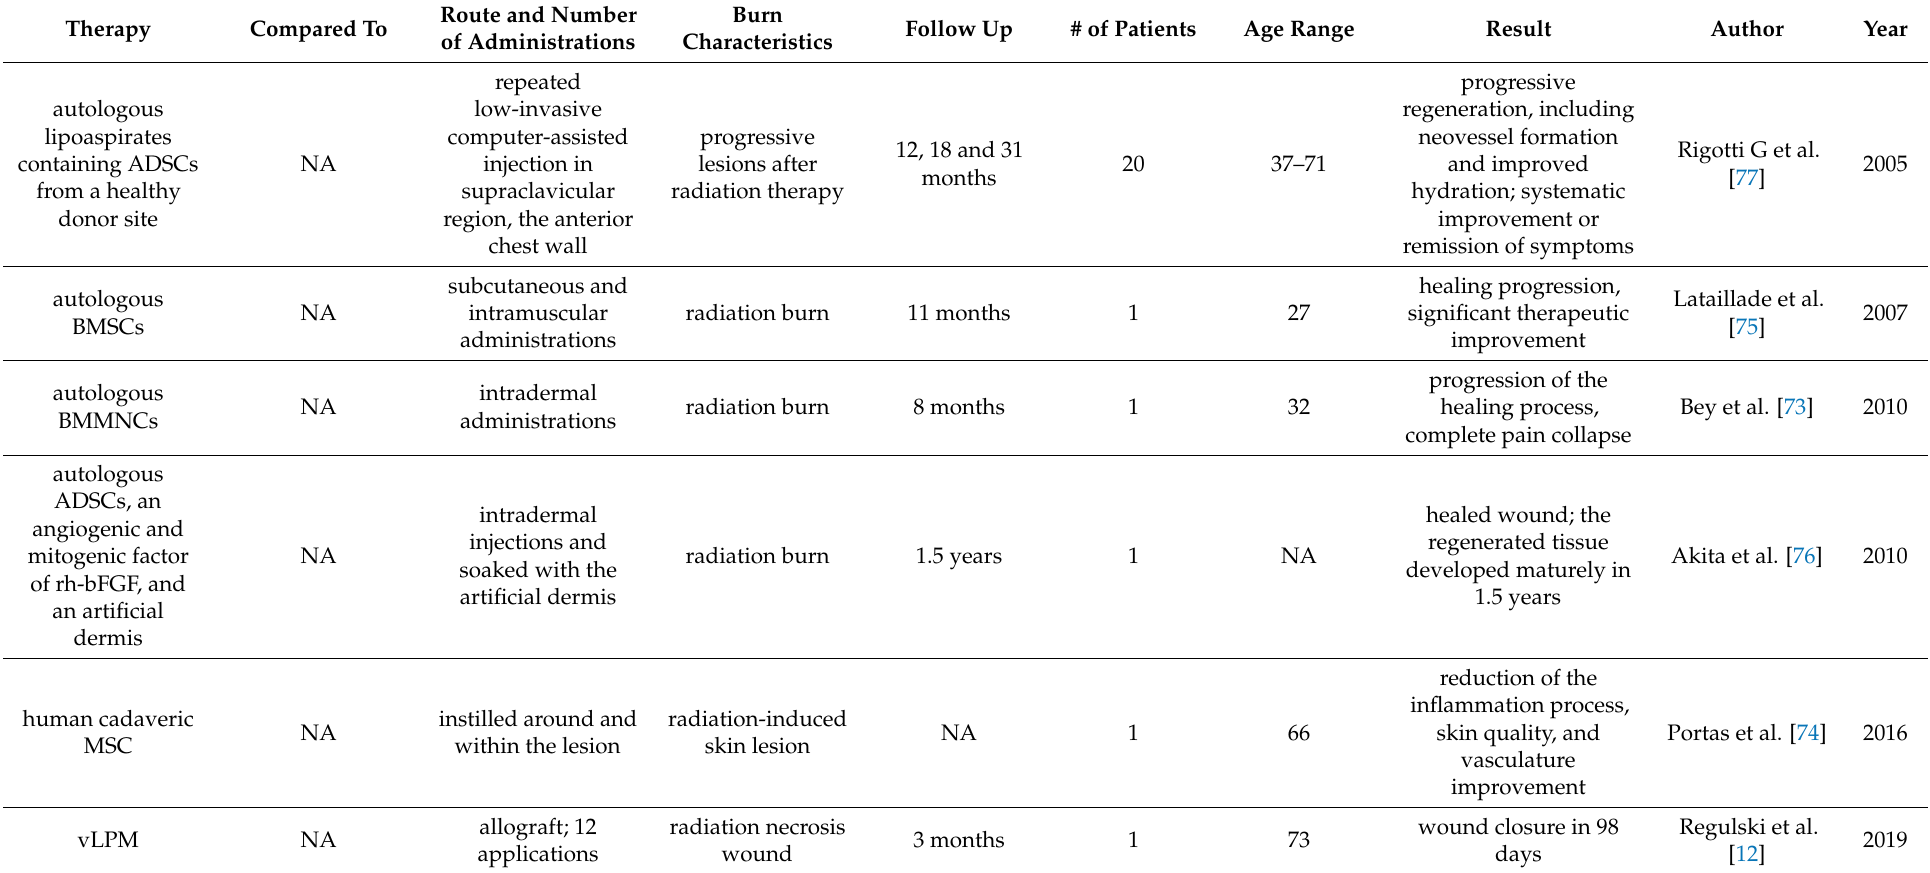
Table 4. Clinical applications of cell-based therapies in radiation burns (BMSCs—bone-marrow mesenchymal stem cells; BMNCs—bone marrow mononuclear cells, ADSCs—adipose- derived stem cells; rh-bFGF—human recombinant fibroblast growth factor; vLPM —lyopreserved placental membrane containing viable